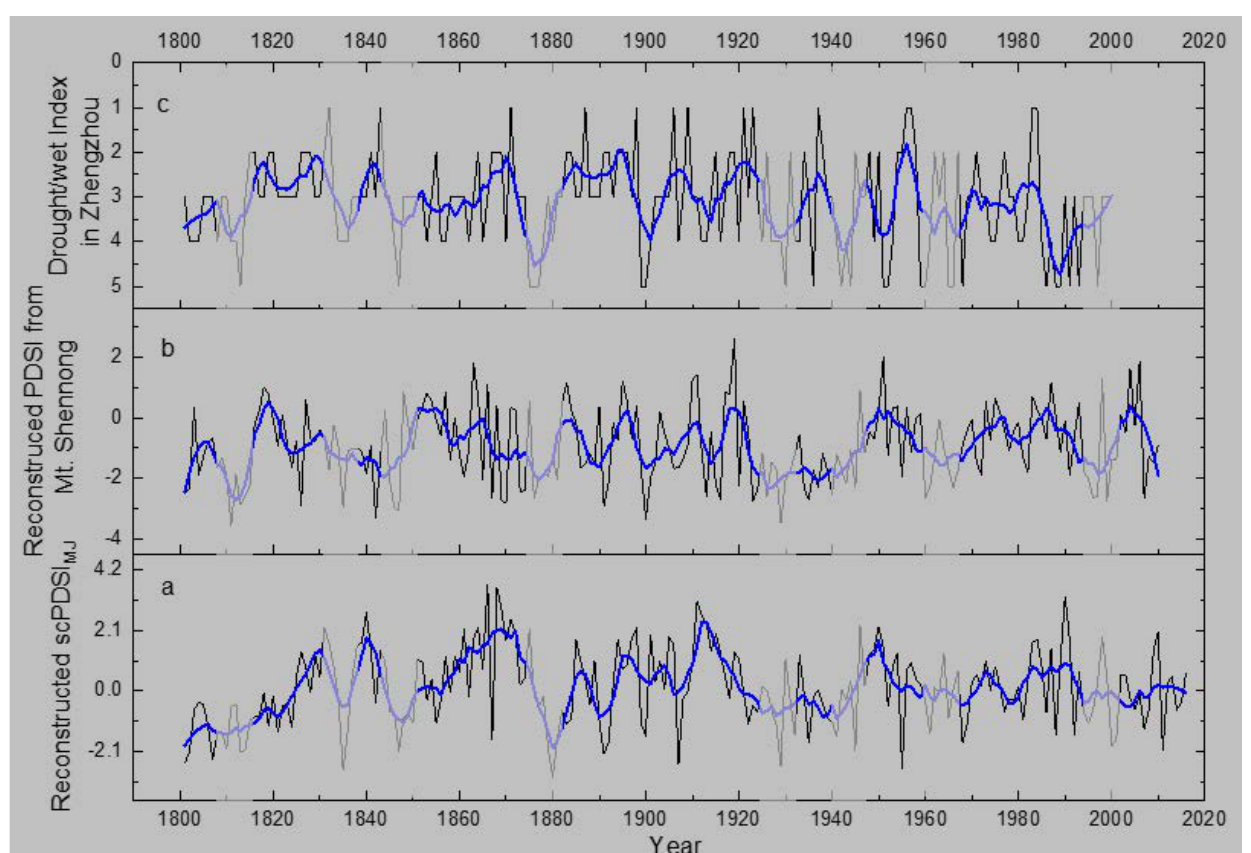
Figure 9. Comparisons of ( a ) reconstructed regional scPDSI MJ , ( b ) reconstructed PDSI from Mt. Shennong [12], and ( c ) drought/wet index in Zhengzhou [39]. The gray bars represent the same drought periods in three